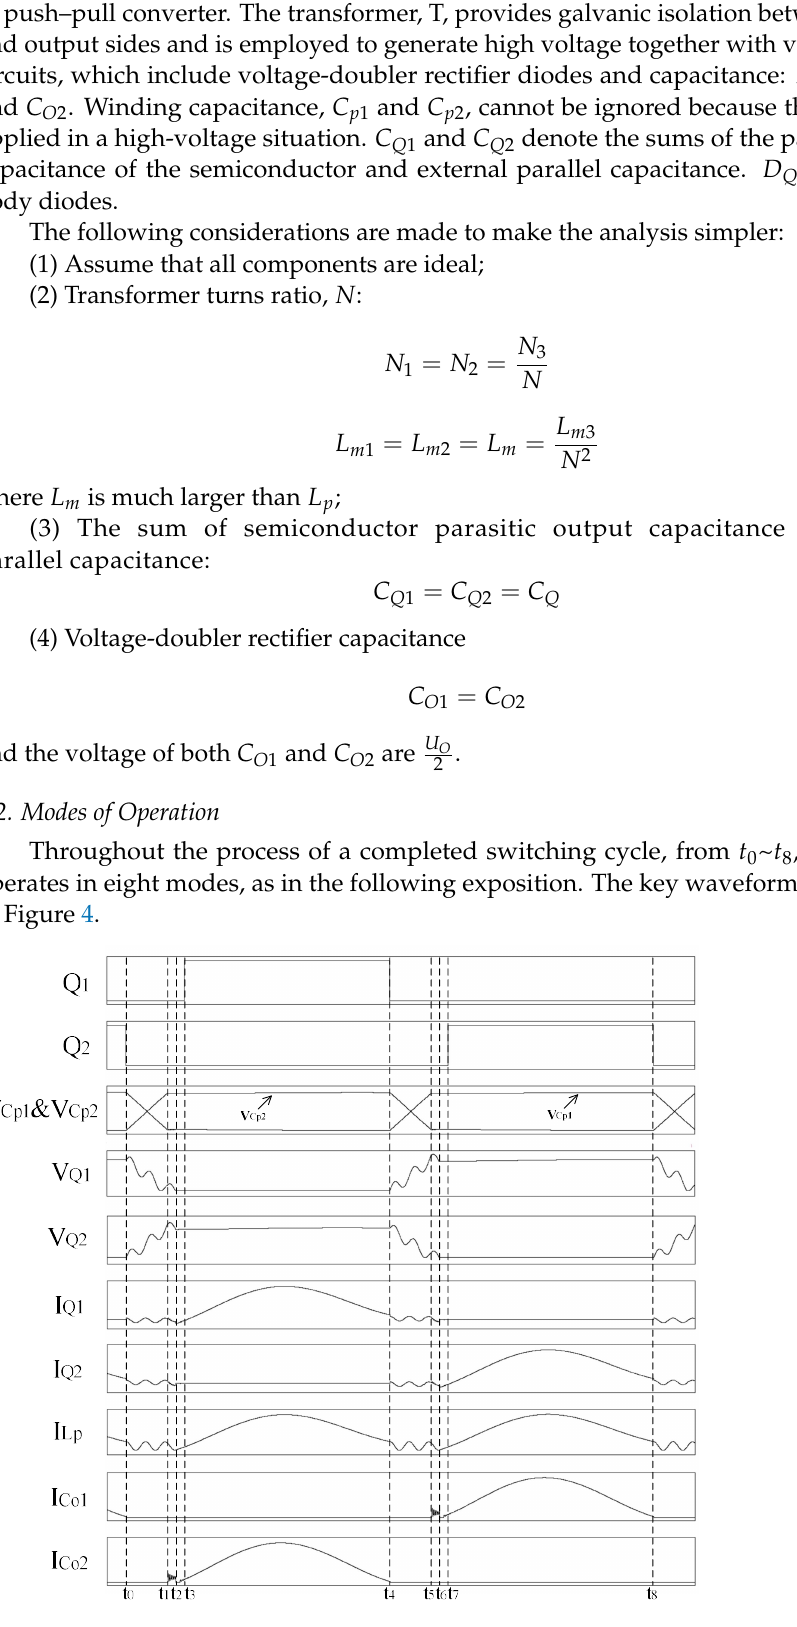
Figure 4. The key waveforms in a complete switching cycle.